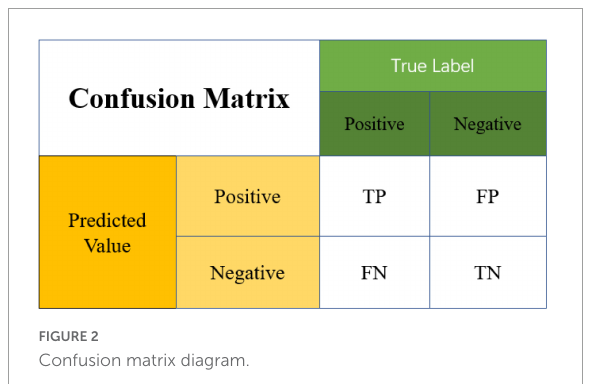
FIGURE2 Confusion matrix diagram.